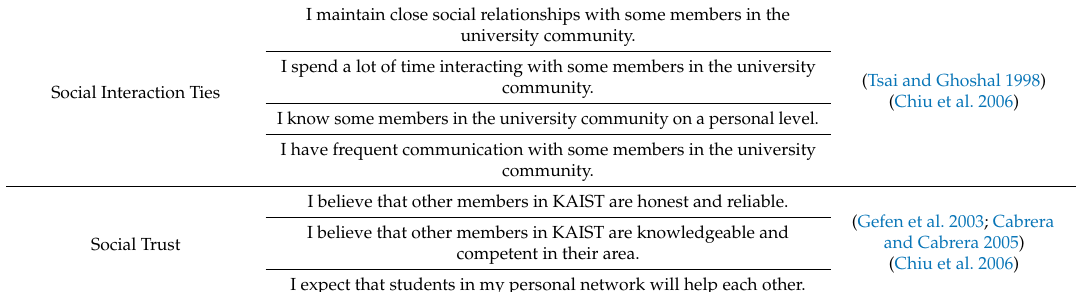
Table A1. Measurement items. KAIST—Korea Advanced Institute of Science and